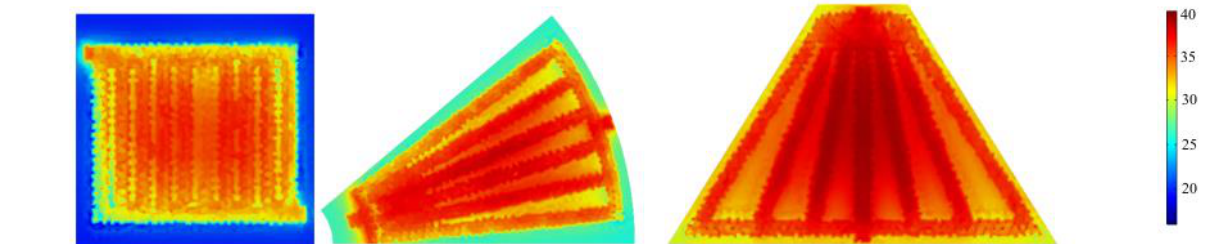
Figure 8. The 2,6-reDHAQ concentration distribution of the 3L/4 cut plane at 0.2 SOC.